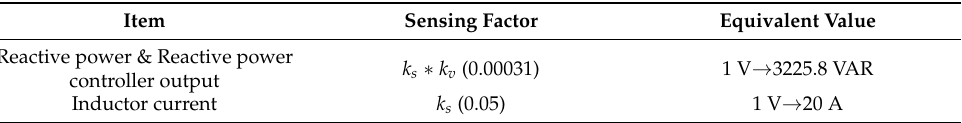
Table 3. Equivalent values of control